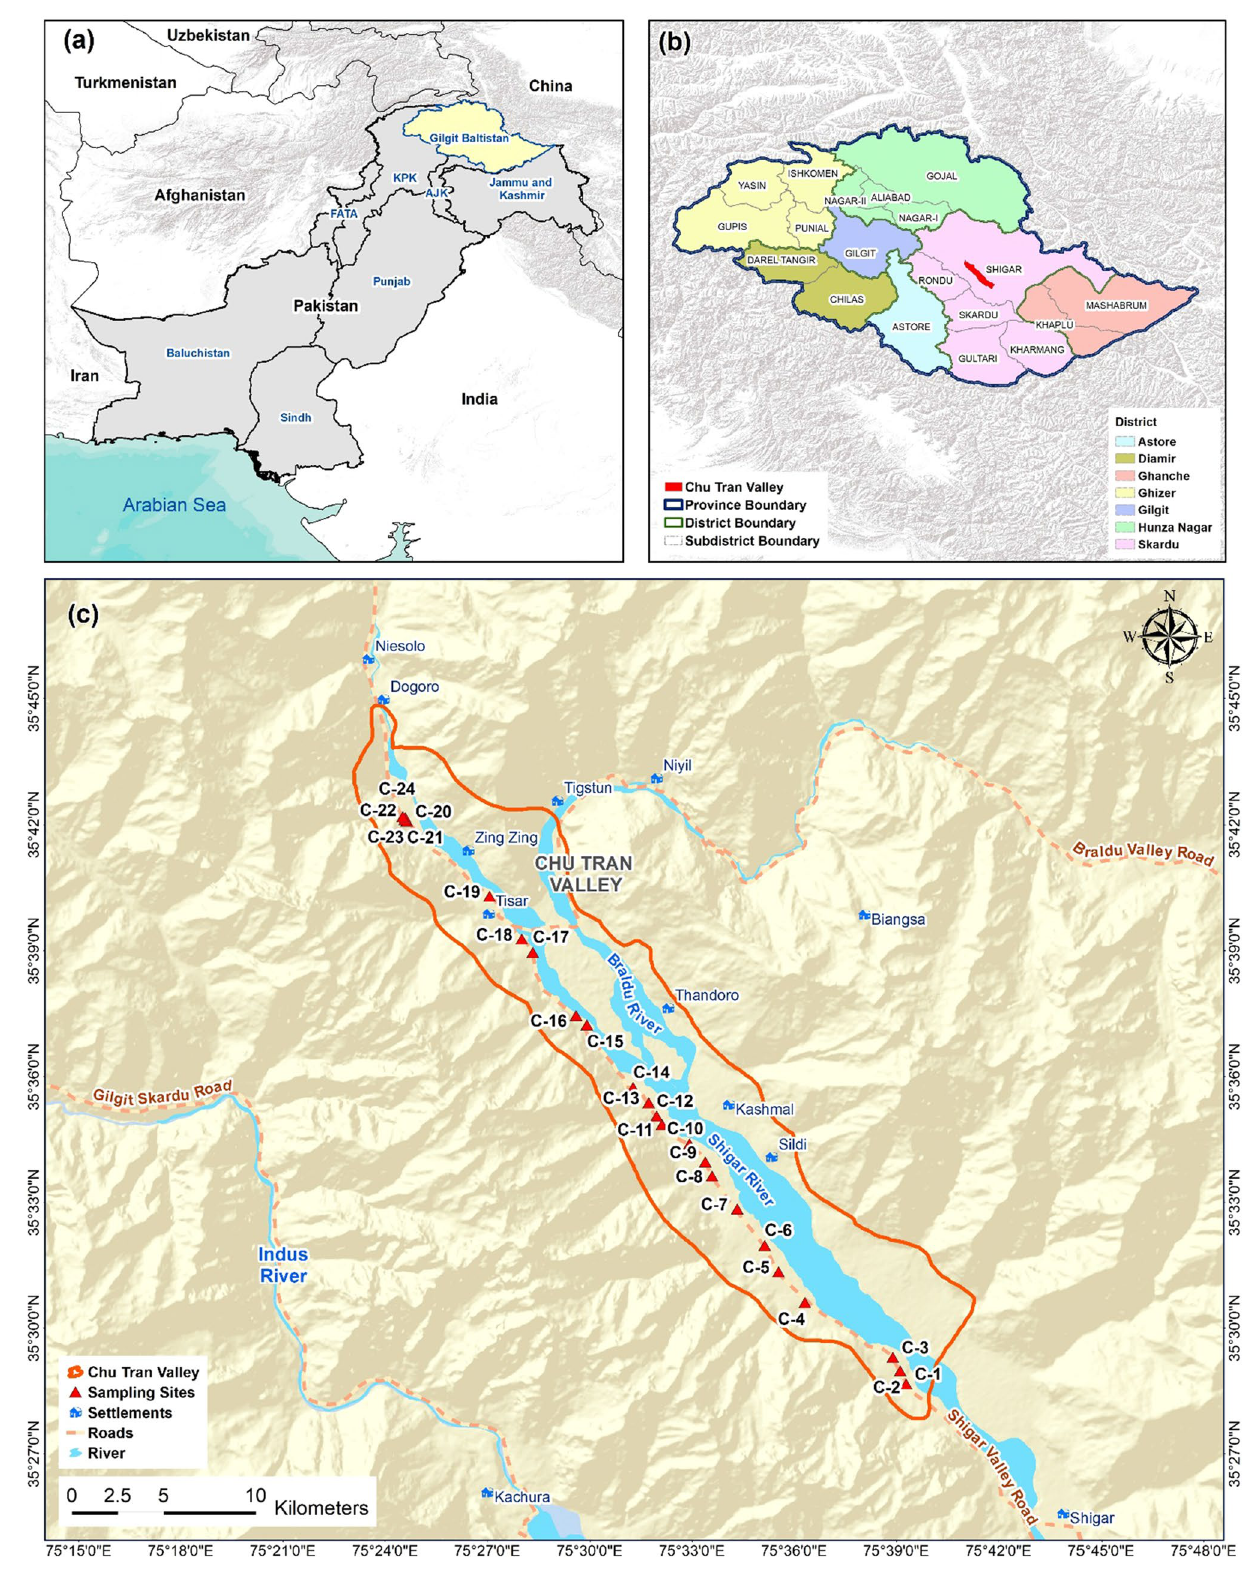
Fig. 1 Location of a Gilgit Baltistan (GB) in Pakistan; b Shigar district in GB; and c Chu Tran Valley (study area) and sampling sites along with nearby rivers, settlements and